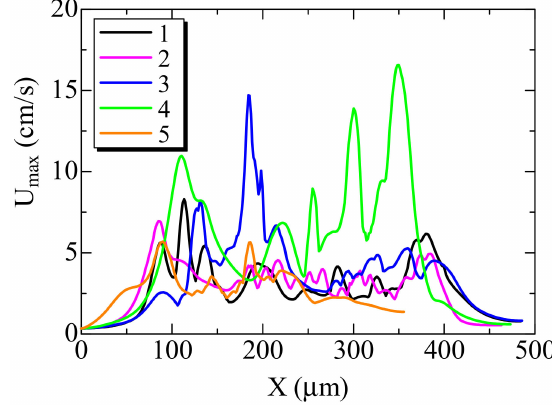
Figure 8. Distributions of maximum filtration velocity inside DPF for five